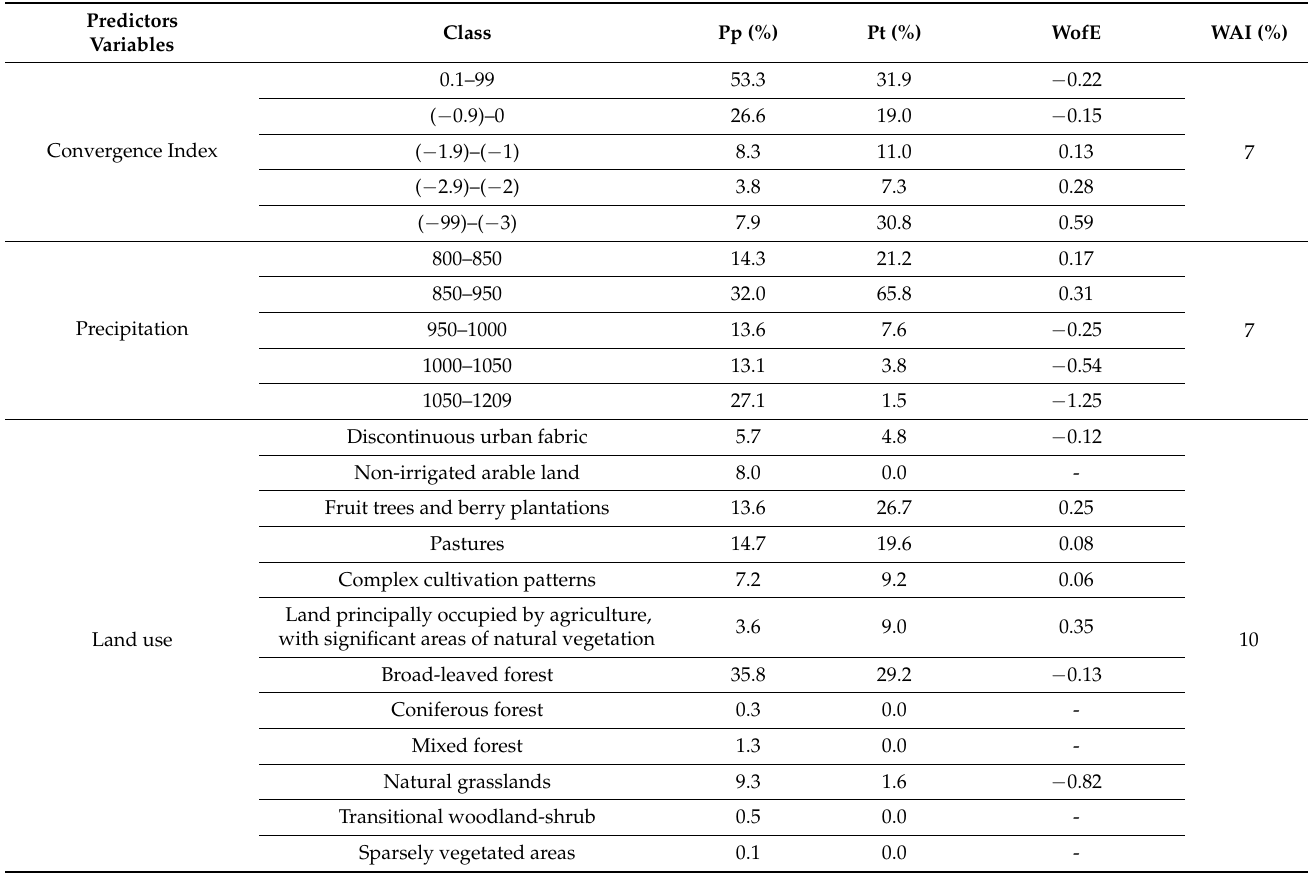
Table 2. Flash flood predictor variables classes with their WofE results.